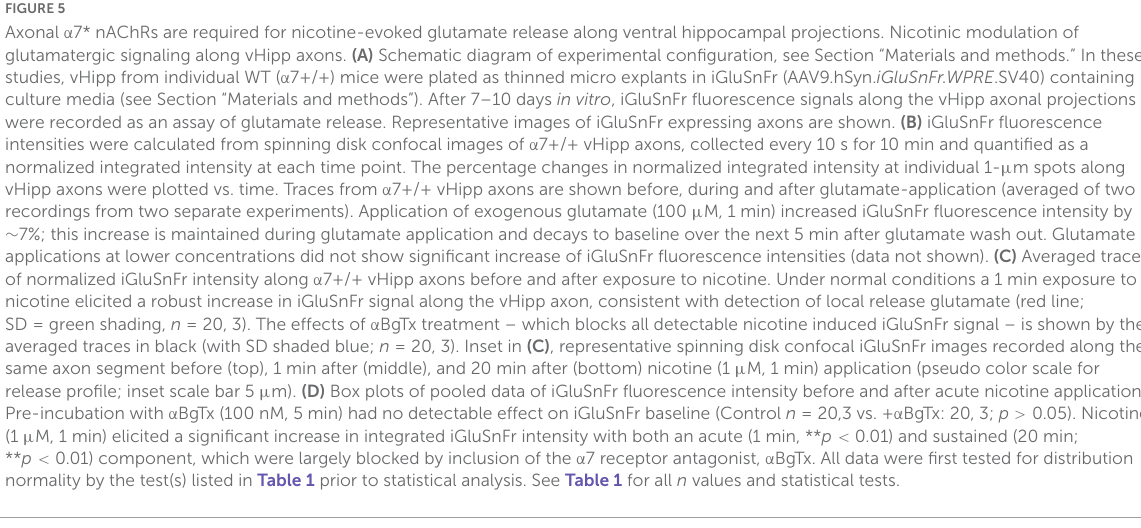
( Figure 8A , left top) and α 7 knockout ( − / − ) ( Figure 8A , right top) vHipp axons, and showed no differences in the initial FM1-43 fluorescence intensities after K + -dependent loading ( Figure 8B ), the α 7 knockout ( − / − ) vHipp axons had more (KO: 38.4 ± 4.2 clusters/100 µ m vs. WT 27.8 ± 3.1 clusters/100 µ m; p < 0.01) and smaller FM1-43